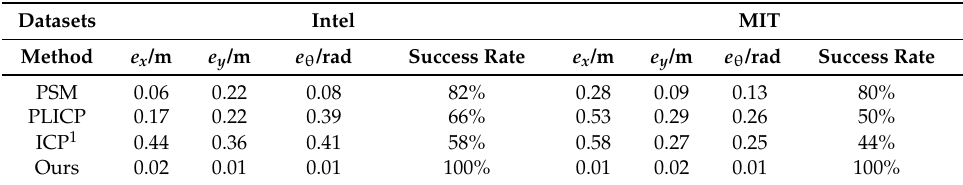
Table 3. Quantitative evaluation on Intel and MIT datasets.